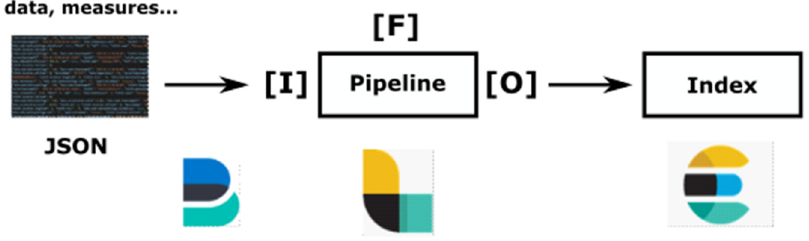
Figure 6. Input-Filter-Output process (from [44]).